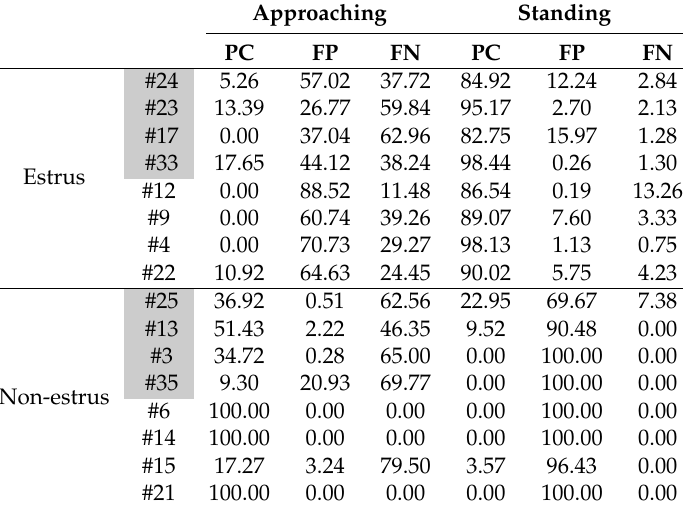
Table 4. PCs, false positives, and false negative of estimation using neural networks. Gray-colored cells represent goats used for training